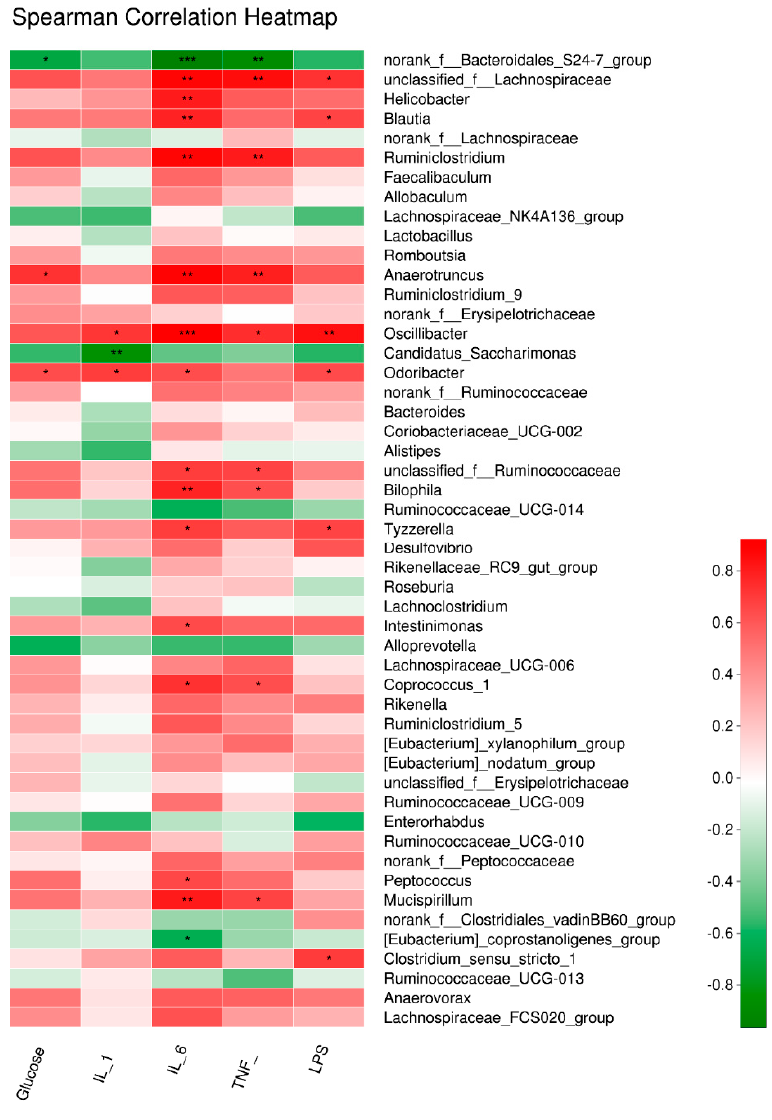
Figure 6. Correlation analysis between T2D-related biochemical parameters and the relative abundance of gut microbiota at genus level. A positive correlation was represented by red while a negative correlation was shown in green in the heap map. Statistical significance was calculated by Spearman’s rho non-parametric correlation analysis (* p < 0.05, ** p < 0.01, *** p < 0.001).